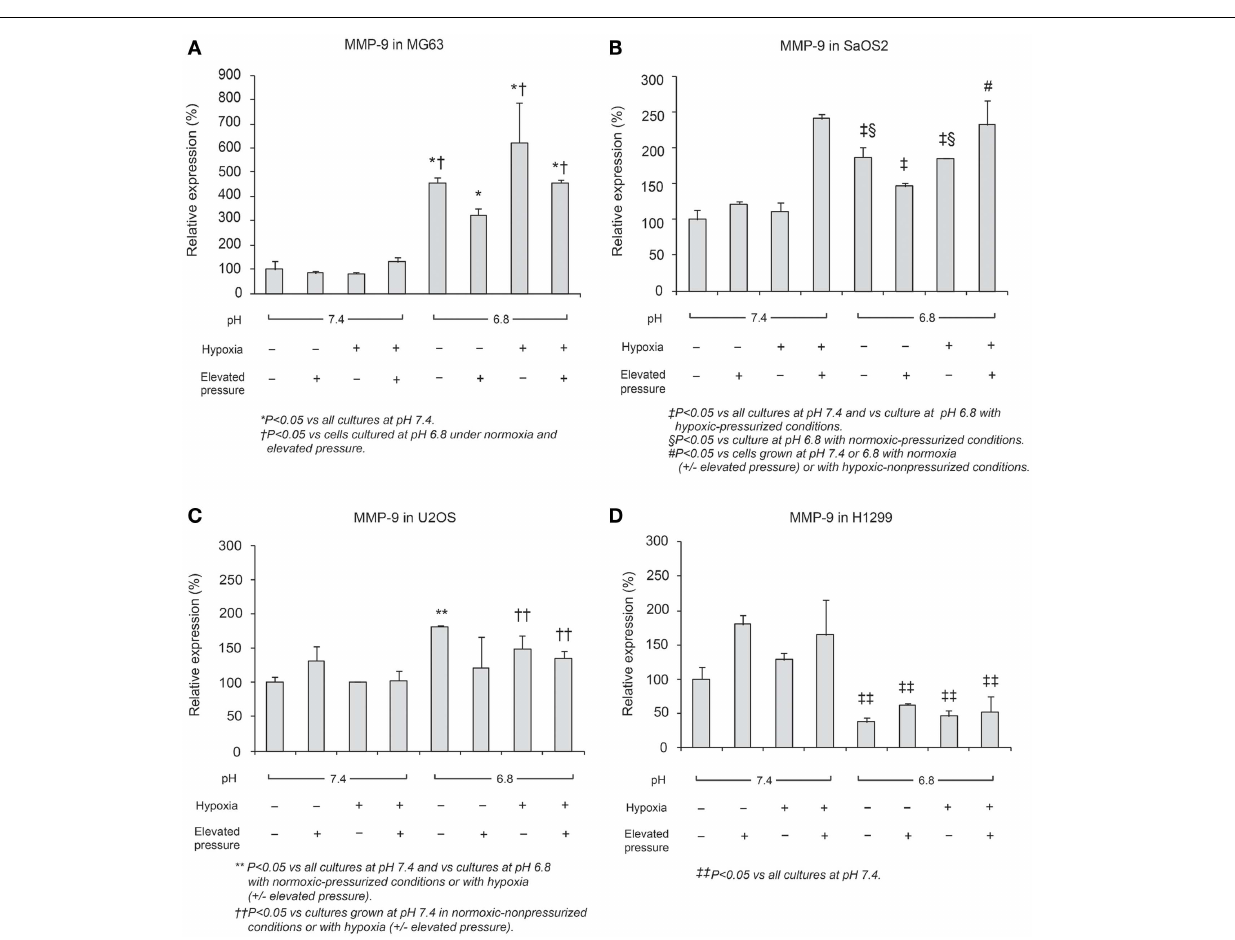
FIGURE 6 | Relative expression levels of MMP-9 mRNA, determined via quantitative real-time PCR, in four tumor cell lines: (A) MG63, (B) SaOS2, (C) U2OS, and (D) H1299 .The number on each graph is the maximum level of the target mRNA/HPRT in each cell